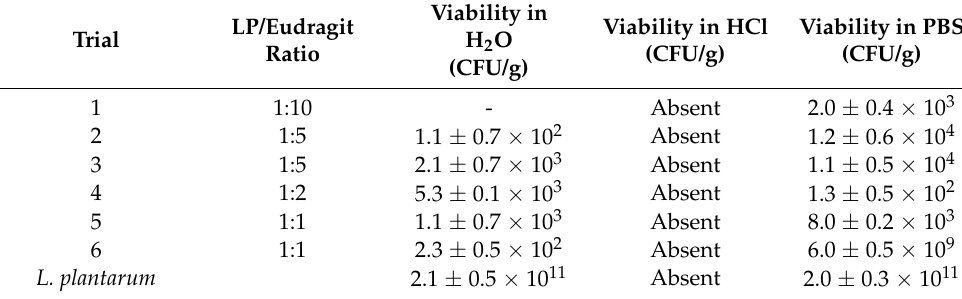
Figure 7. Coating removal observed by optic microscopy (100 × ) after 3 h and 6 h in PBS. Table 4. Quantity assays performed on coated L. plantarum according to method B, compared to uncoated